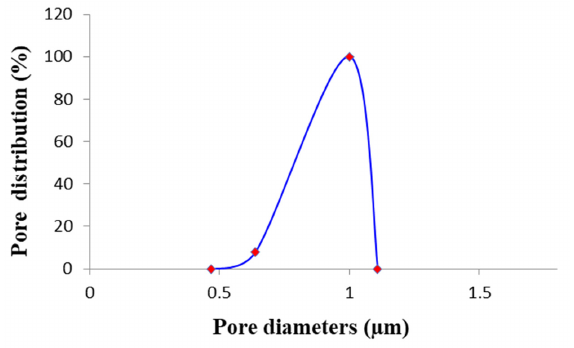
Figure 6. Pore distribution of the M5 ENM.